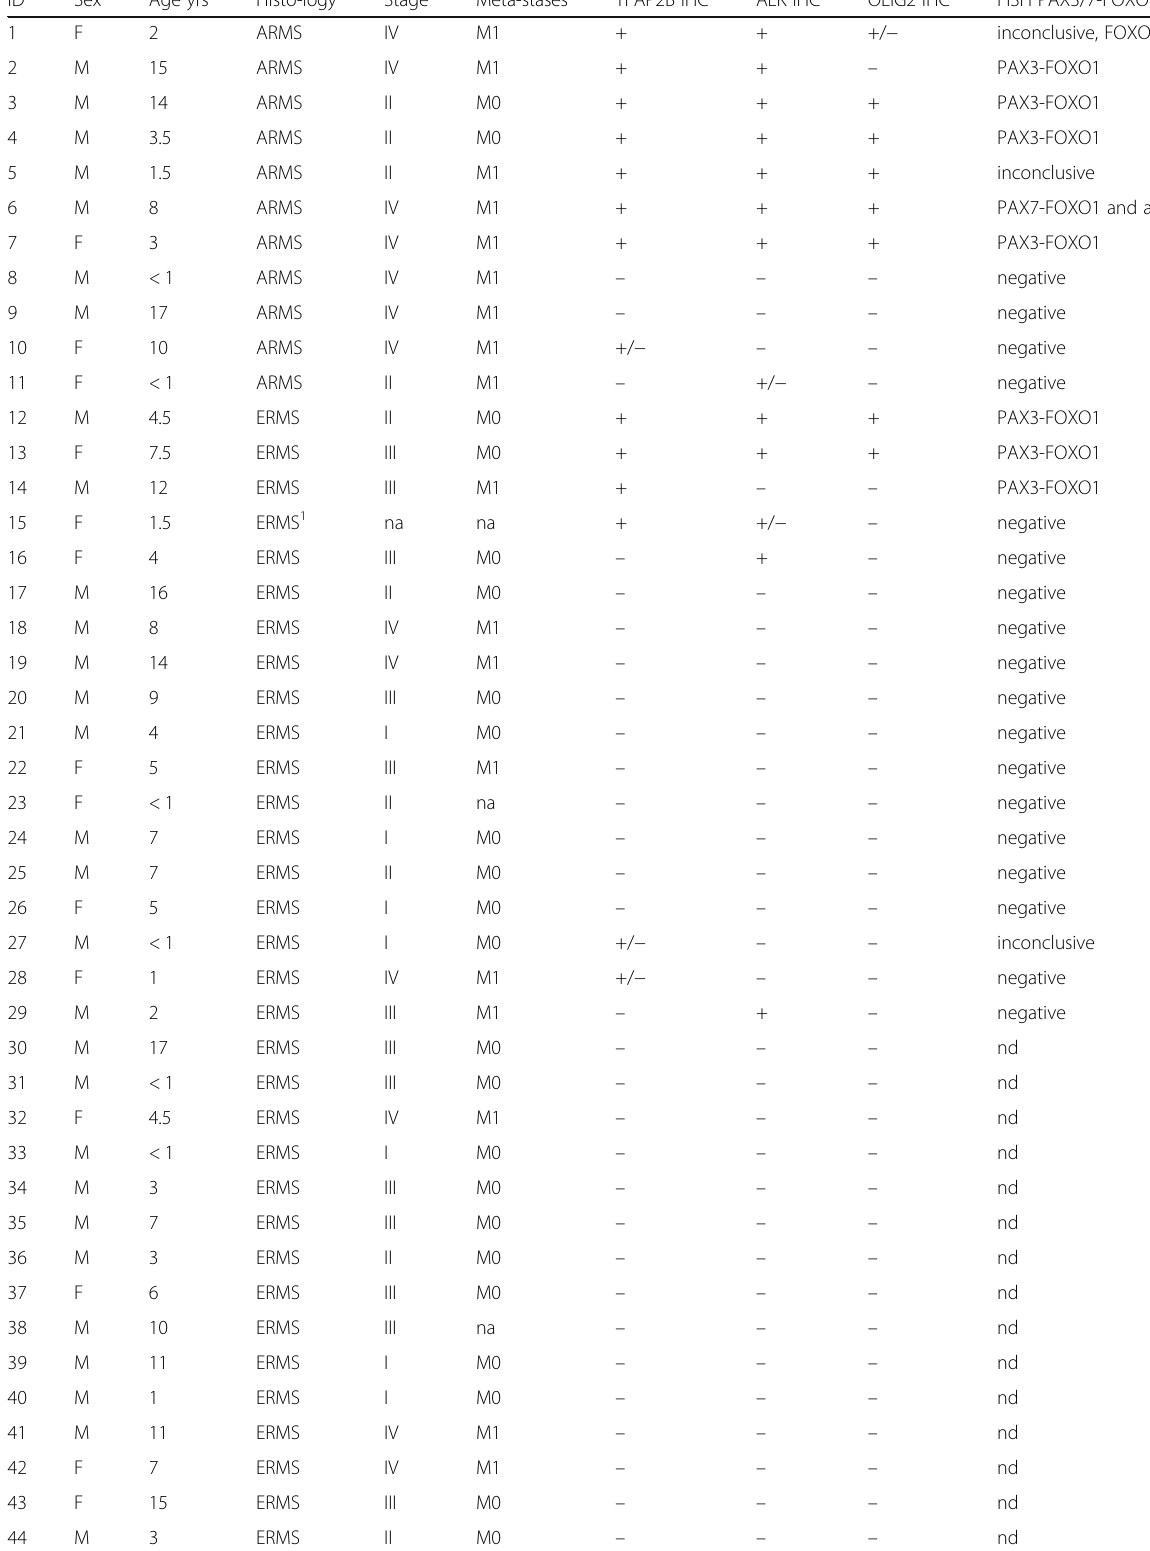
Table 2 List of patients with clinical, immunohistochemical and FISH